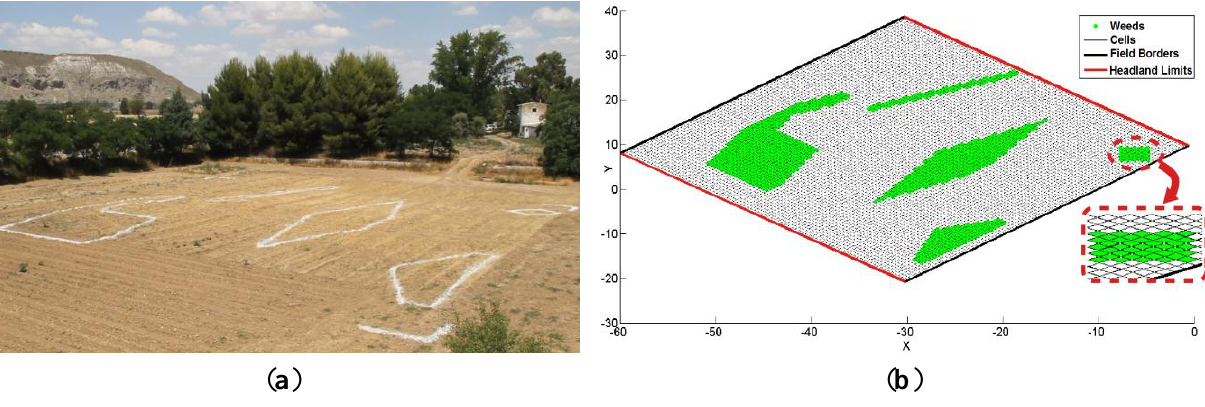
Figure 5. Actual test field and its computer representation. Map of the field and weeds used for the tests. The white markings define the areas of weed